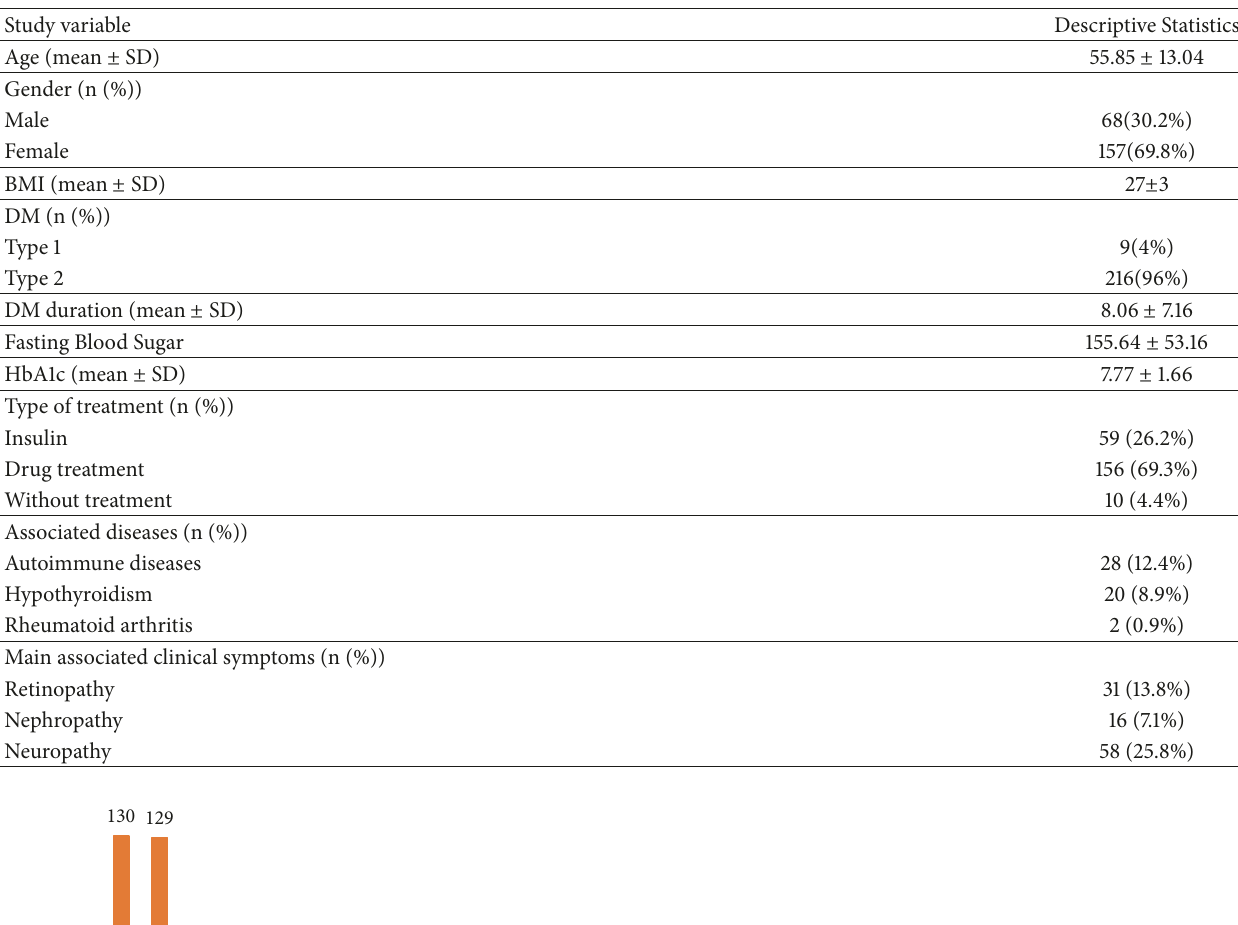
Table 1: Descriptive summary of study sample.